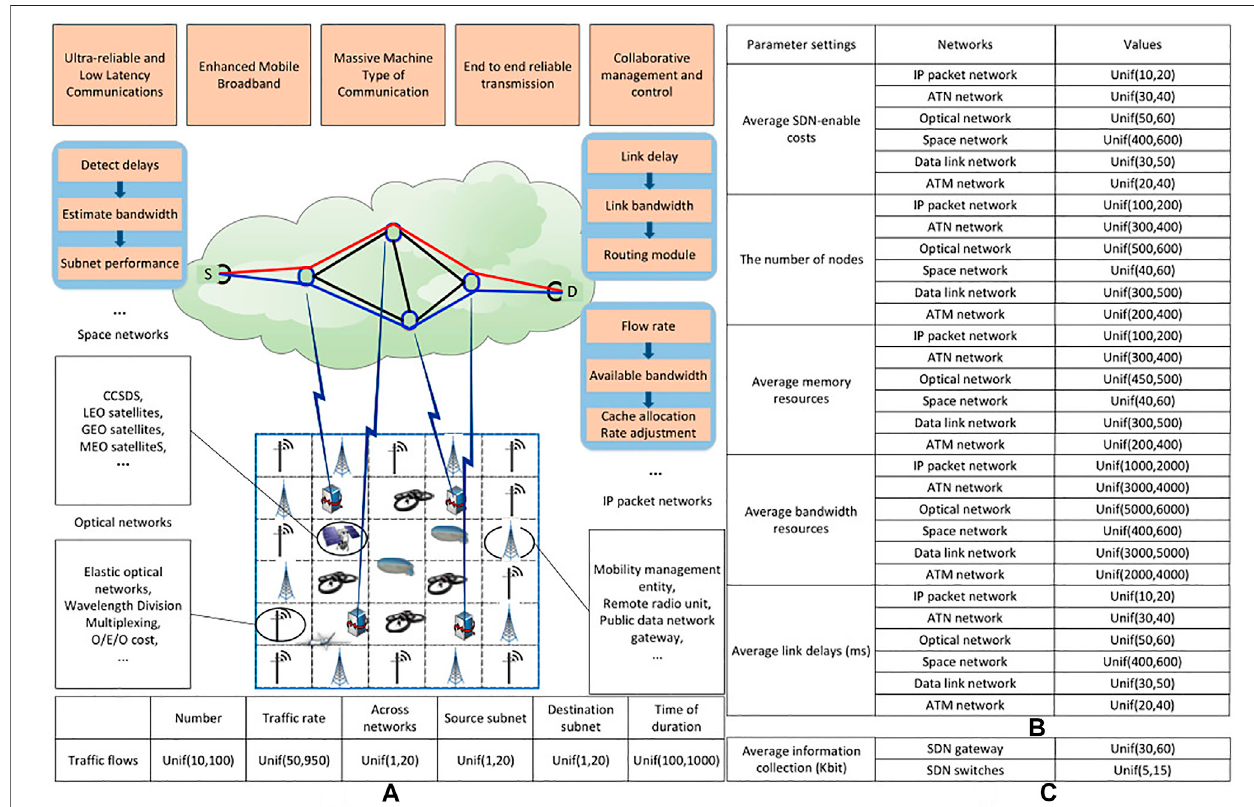
FIGURE 5 | Application case study and performance quantitative analysis of the SD-SGN architecture.